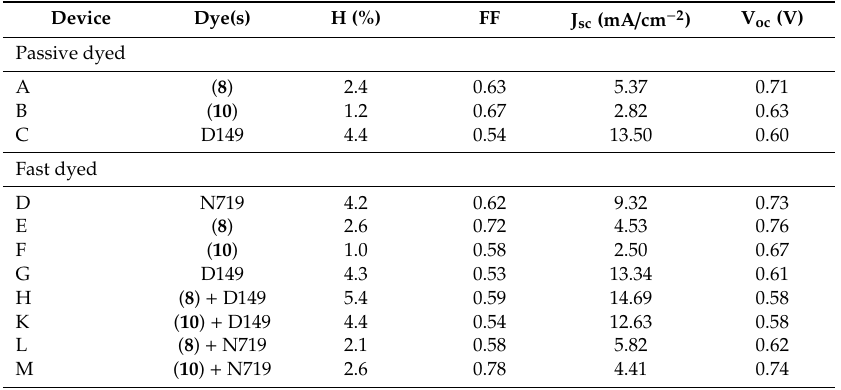
Table 2. I-V testing data for ( 8 ), ( 10 ), N719 , and D149